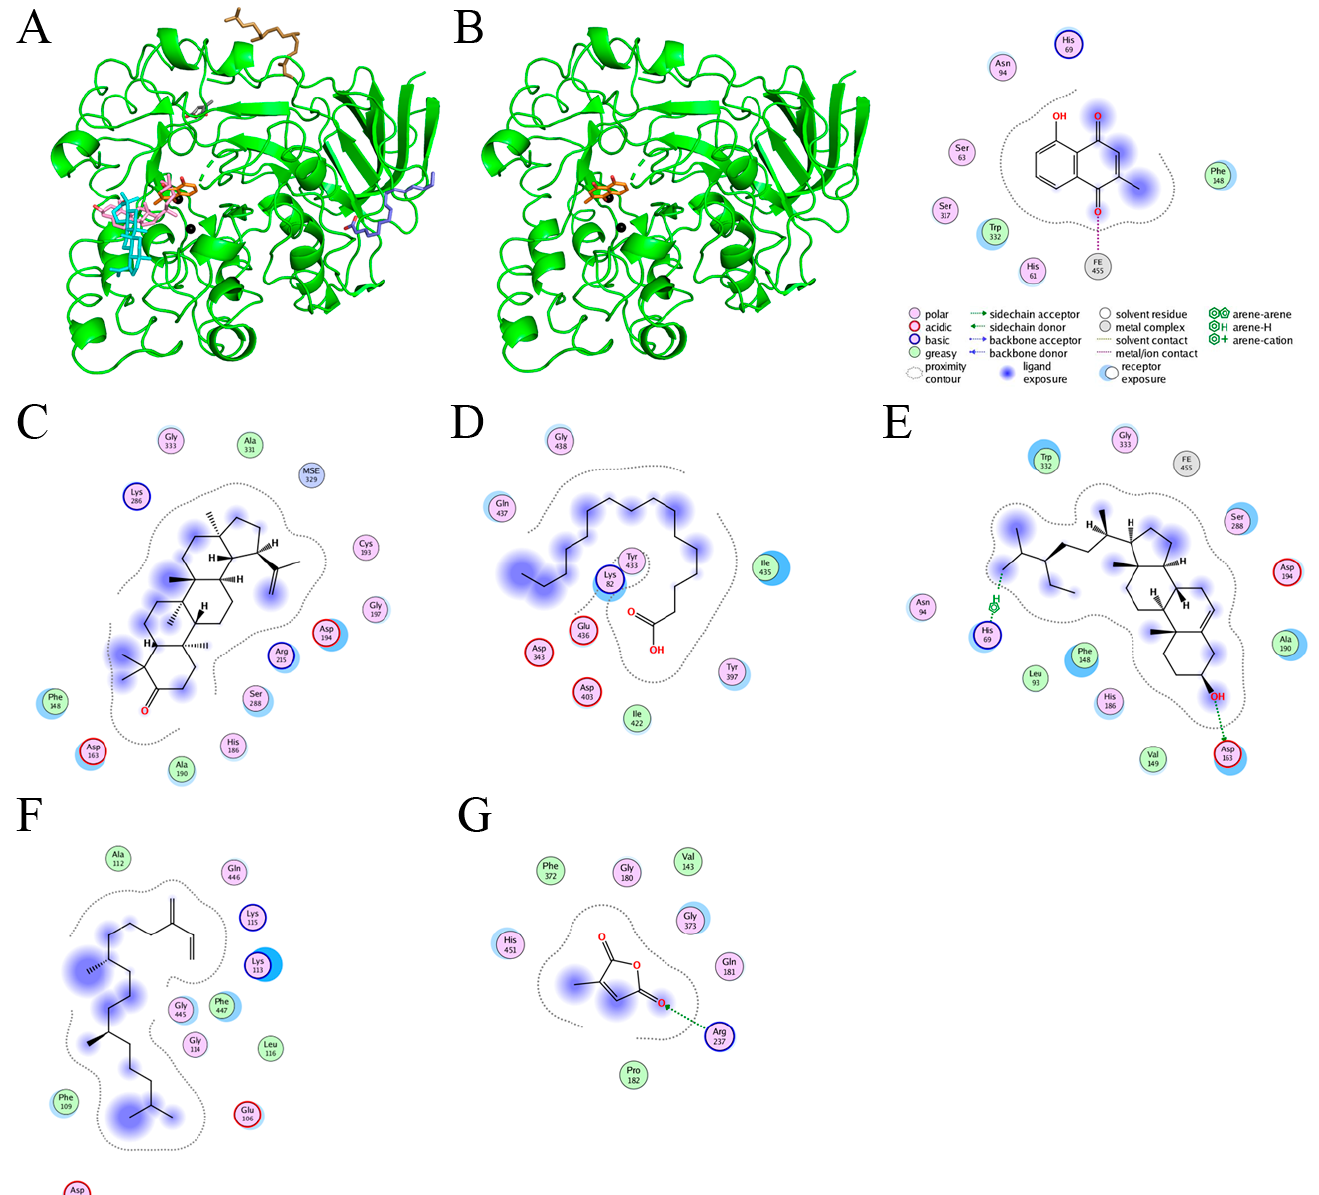
Figure 8. Molecular docking. ( A ) Docking results. Through MOE-Dock, ALLase–ligand binding affinities with all possible binding geometries could be predicted on the basis of the S score. The PDB ID of the used structure of ALLase (green) is 3E74. This enzyme contains a binuclear metal center. Two Fe ions in the active site are presented as black spheres. The top 6 compounds in N. miranda - leaf-acetone, namely plumbagin (orange), lupenone (cyan), palmitic acid (slate), stigmast-5-en-3-ol (lightpink), neophytadiene (sand), and citraconic anhydride (gray), were docked to ALLase. Only plumbagin could be docked into the active site of ALLase. ( B ) The binding mode of plumbagin to ALLase. ( C ) The binding mode of lupenone to ALLase. ( D ) The binding mode of palmitic acid to ALLase. ( E ) The binding mode of stigmast-5-en-3-ol to ALLase. ( F ) The binding mode of neophyt- adiene to ALLase. ( G ) The binding mode of citraconic anhydride to ALLase. Table 4. Results of the docking studies against ALLase.